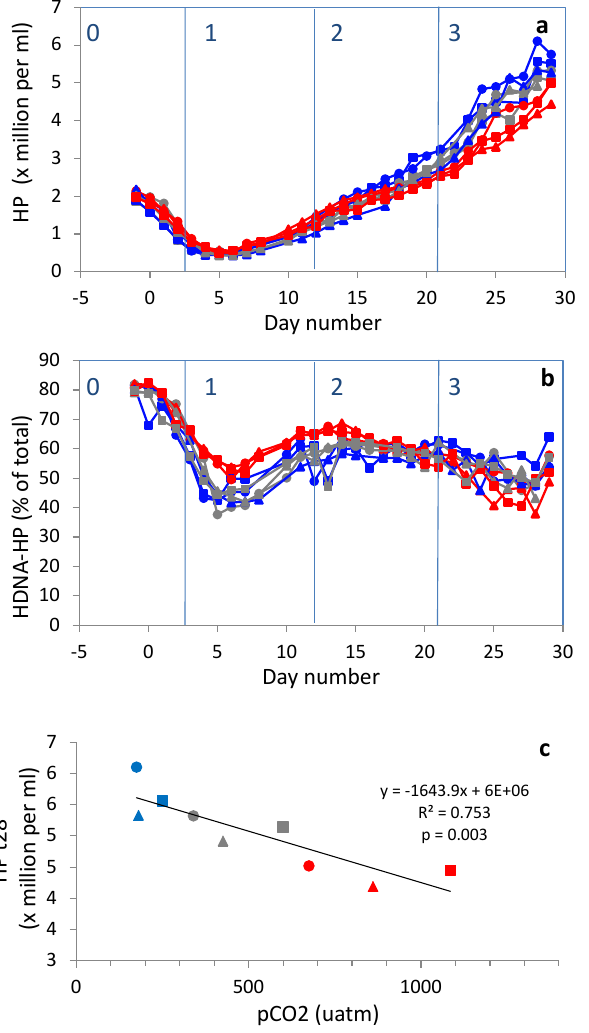
Fig. 8. Temporal dynamics of total viruses (a) and the virus to HP ratio (b) . Furthermore, the slope of viruses versus HP, thus repre- senting the average number of viruses per HP, for each mesocosm is plotted versus the concurrent p CO 2 (averaged over t 8 to t 27) in (c) . For color and symbol coding, see Fig. 1. For (c) , the linear re- gression statistics are provided in